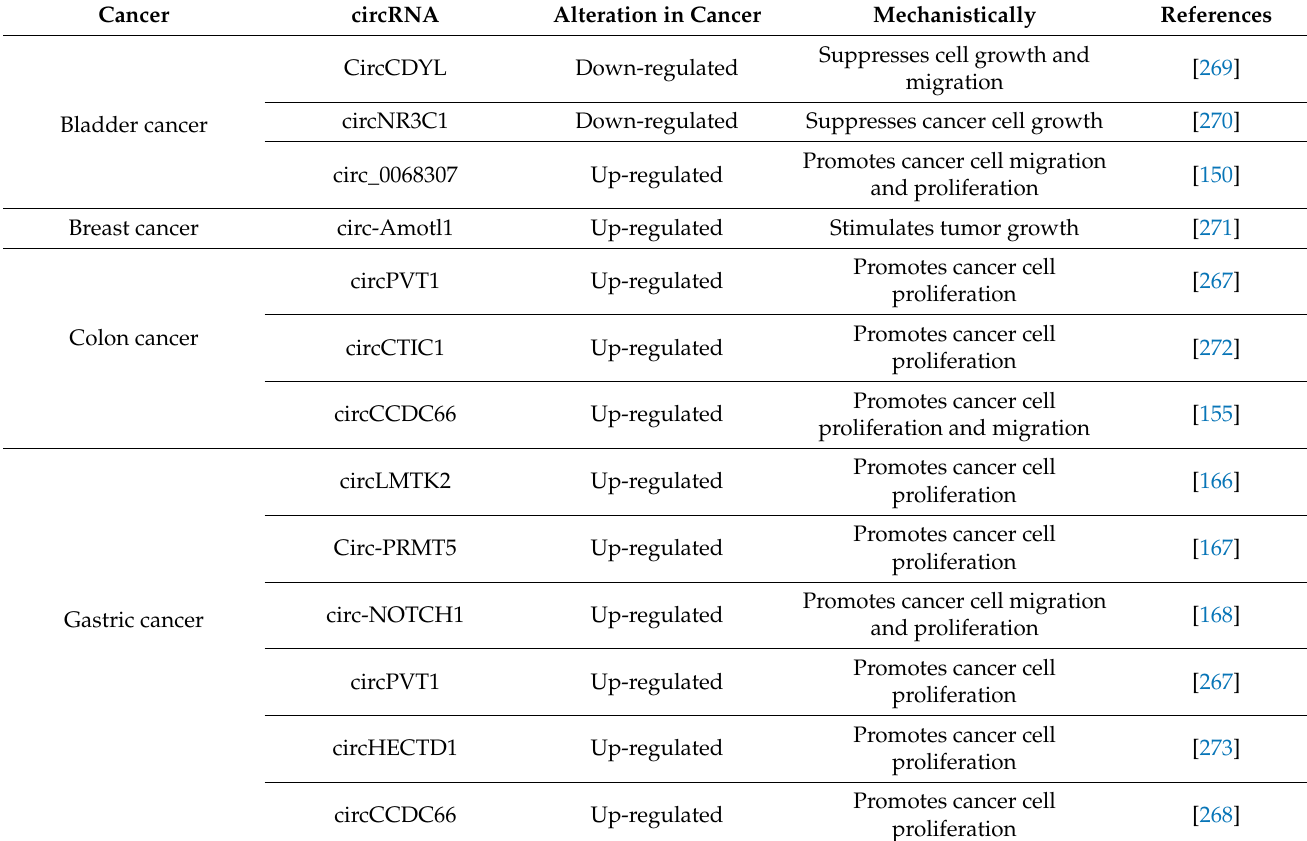
Table 3. CircRNAs that control the expression of the MYC gene in tumors of various human organs. Cancer circRNA